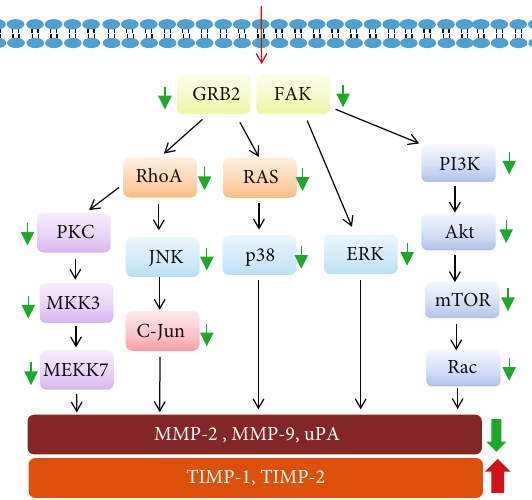
Figure 8: Hypothetical illustration of the Stellettin B associated pathway in HA22T and HepG2